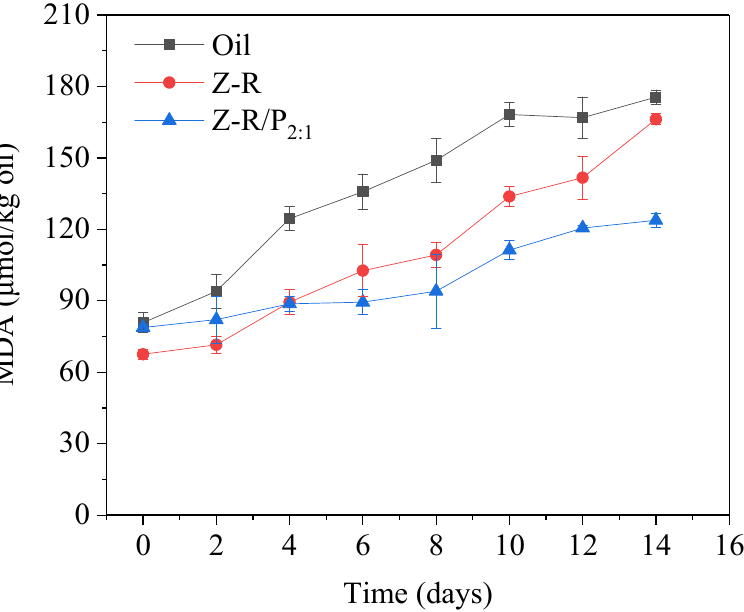
Figure 9. Evolution of malondialdehyde (MDA) under storage at room temperature for 14 days in Z-R-particle-stabilized Pickering emulsion and Z-R/P 2:1 -particle-stabilized Pickering emulsion, with corn oil without stabilizer used as a